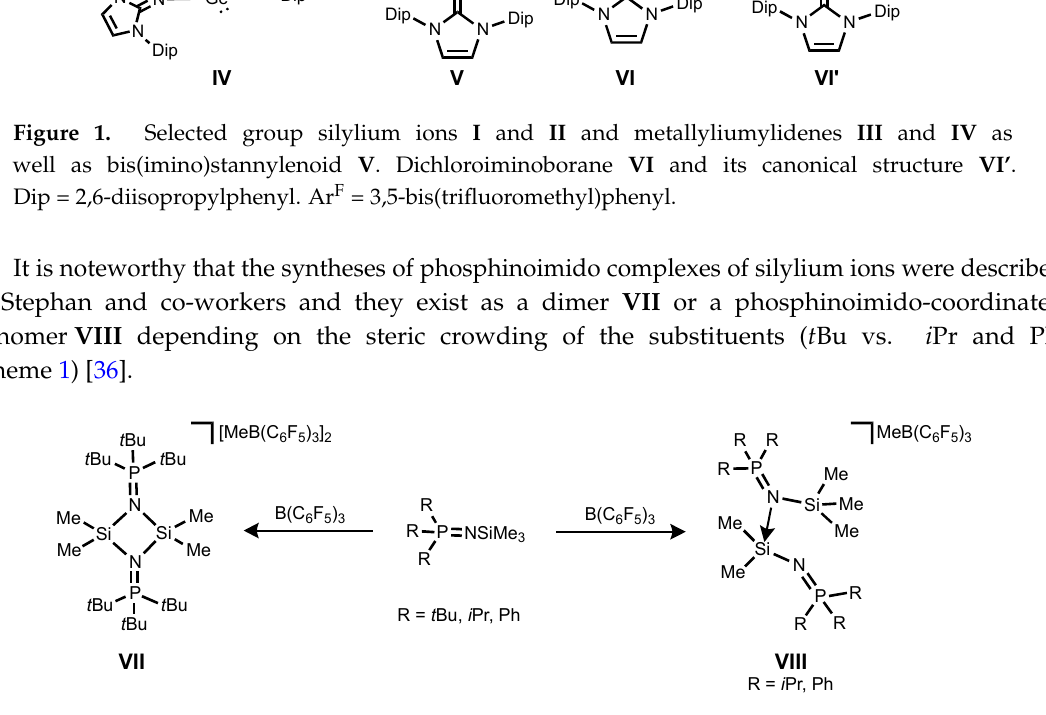
Scheme 1. Syntheses of silylium ions VII and VIII via a methyl abstraction with B(C 6 F 5 ) 3